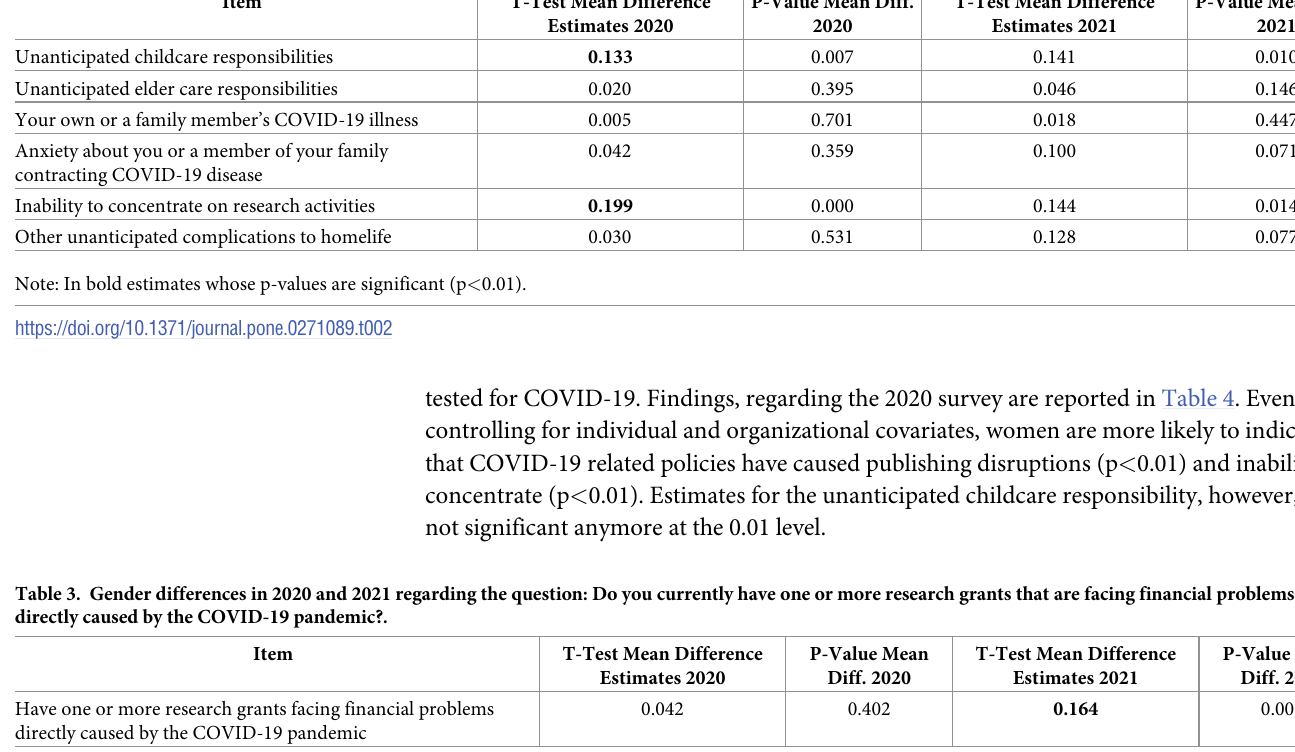
Table 2. Gender differences in 2020 and 2021 regarding the question: Have social distancing and other COVID-19 related policies had a negative impact on your research vis- à -vis any of the following home-life situations?.